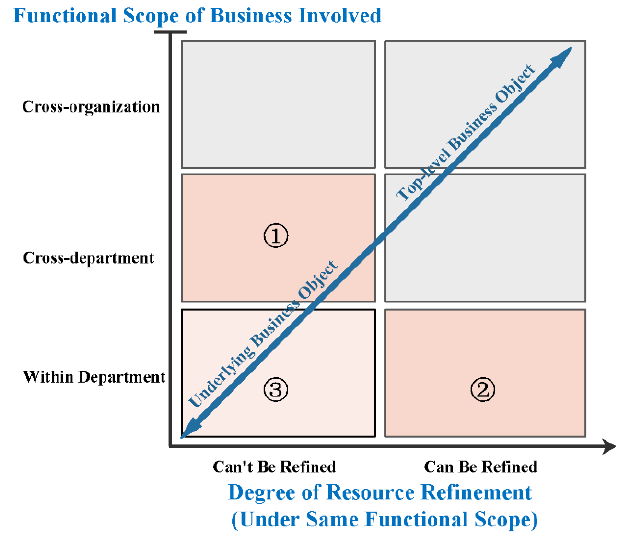
Figure 3. Hierarchical division decision matrix.